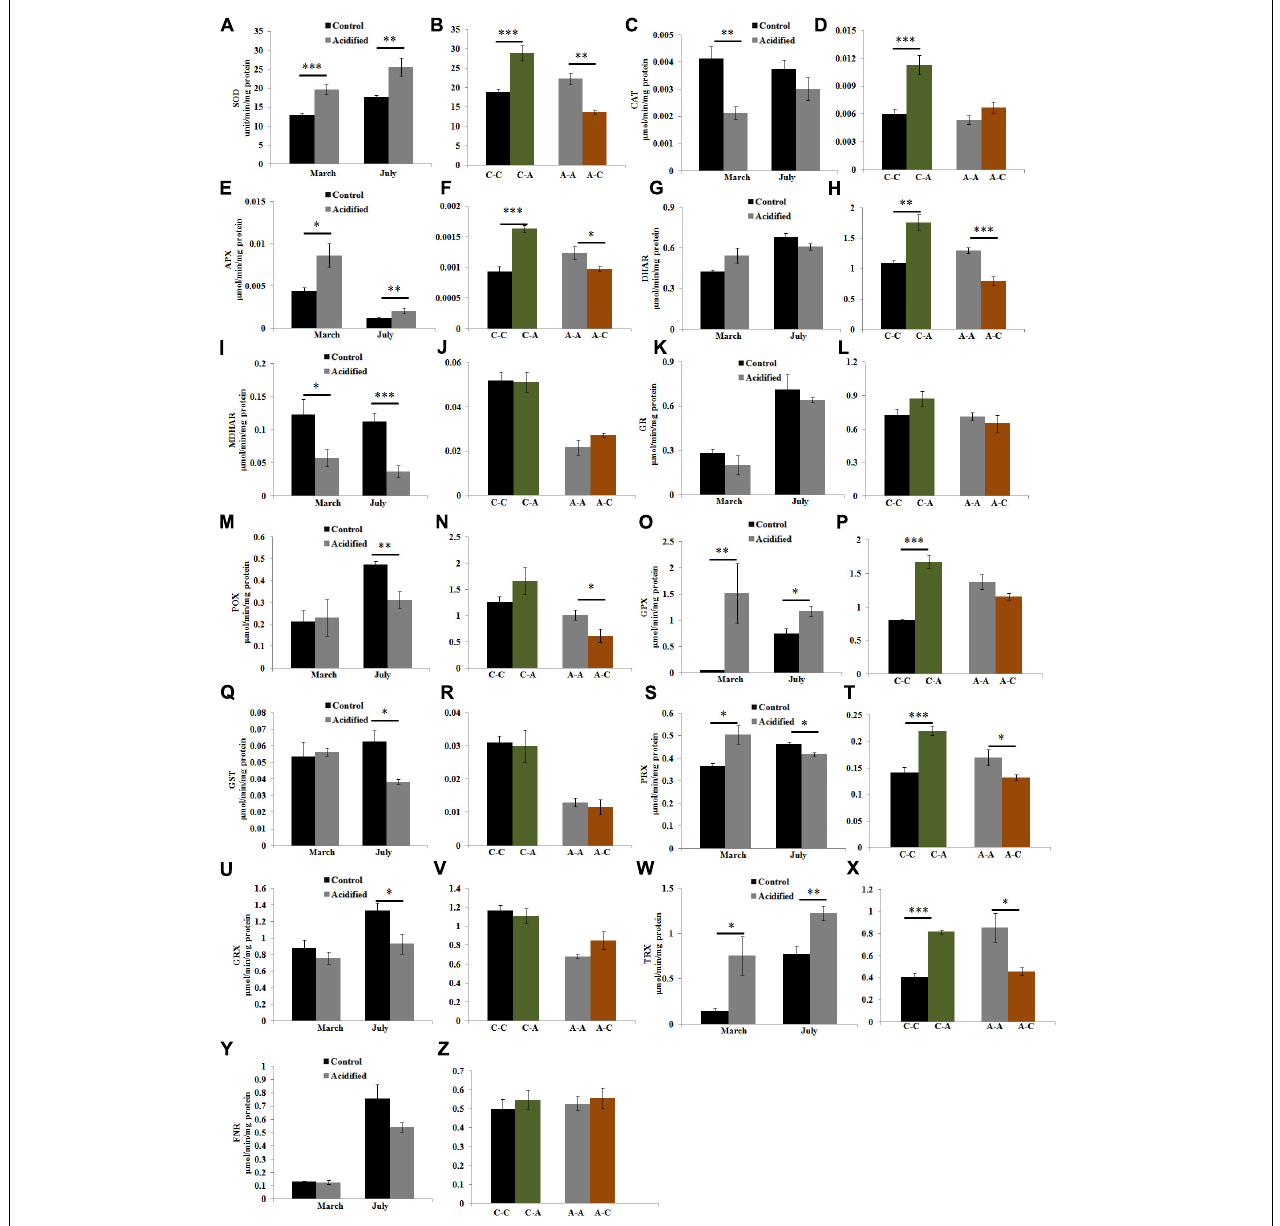
FIGURE 3 | Activities of antioxidant enzymes [superoxide dismutase (SOD), catalase (CAT), ascorbate peroxidase (APX), dehydroascorbate reductase (DHAR), monodehydroascorbate reductase (MDHAR), glutathione reductase (GR), Peroxidase (POX), glutathione peroxidase (GPX), glutathione S -transferase (GST), Peroxiredoxin (PRX), Glutaredoxin (GRX), Thioredoxin (TRX), and Ferredoxin-NADP(H) Reductase (FNR)] in S. vulgare samples collected at the control and the acidified site in March and July (natural populations) (A,C,E,G,I,K,M,O,Q,S,U,W,Y) and after reciprocal transplants (B,D,F,H,J,L,N,P,R,T,V,X,Z) . C-C = control to control, C-A = control to acidified, A-A = acidified to acidified, A-C = acidified to control. Values are mean ± SE, n = 3, ∗ p < 0.05, ∗∗ p < 0.01, ∗∗∗ p <